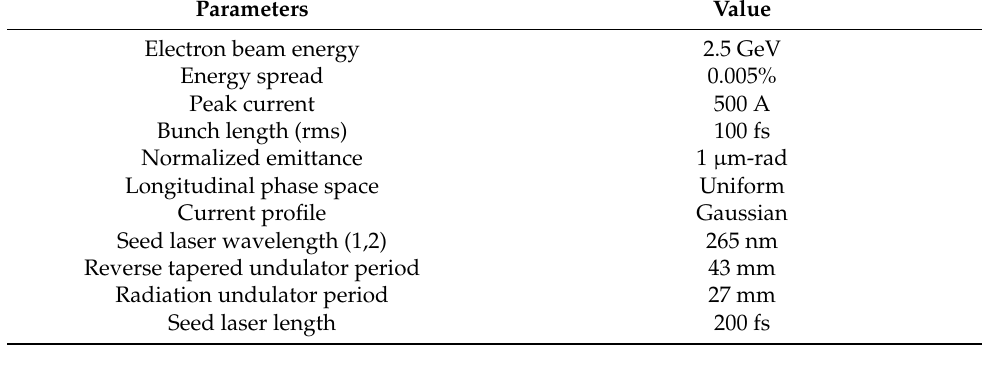
Table 1. Main parameters of a soft x-ray free-electron lasers (FEL) facility.